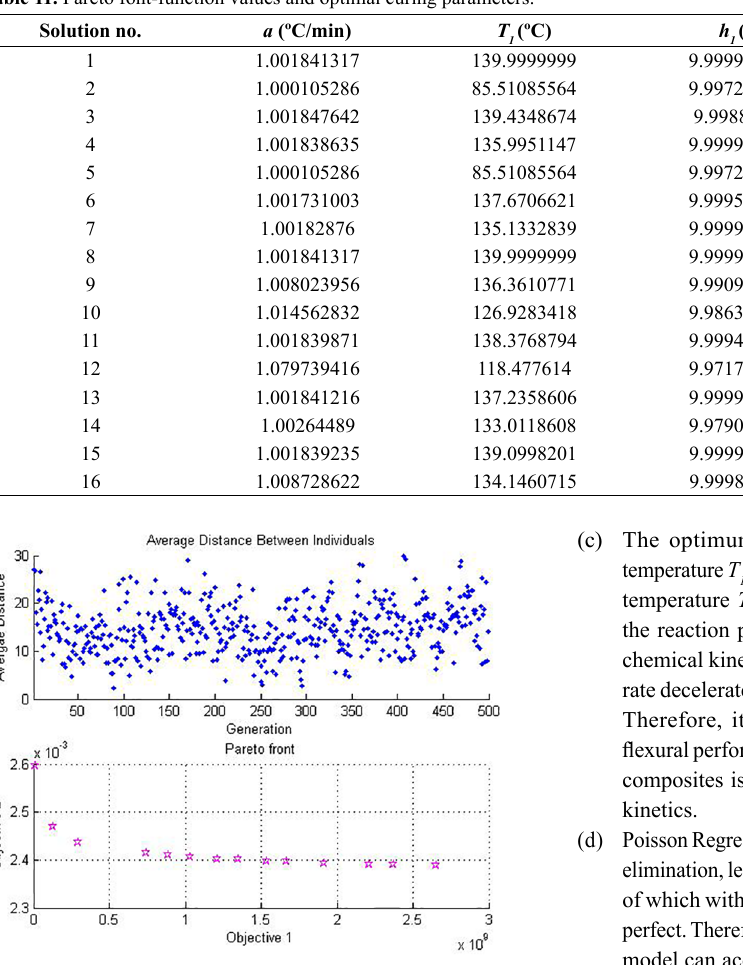
Figure 11. Average distance between individuals per generation and Pareto